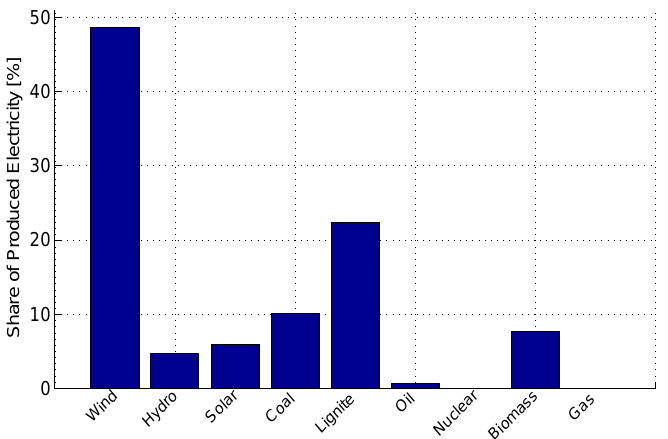
Figure 6. Power production profile for Germany at 12:00 on 21 June 2020; this is the time of the highest wind